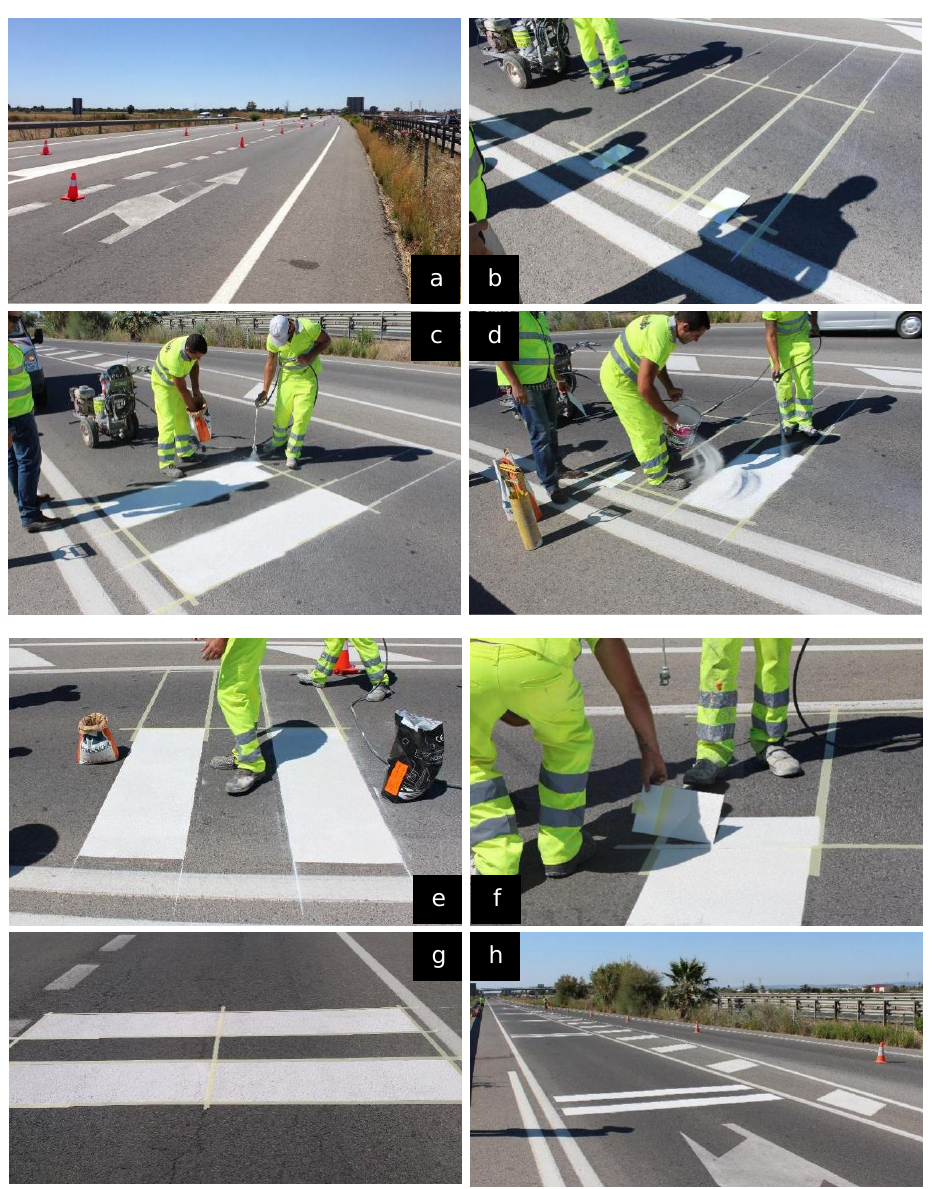
Figure 3. Testing samples labelling: ( a ) Crevillente direction; ( b ) Catral direction. While fabricating each of in situ testing samples, we obtained specimens in a 15 cm × 30 cm metal 4 shows the sample fabrication process.